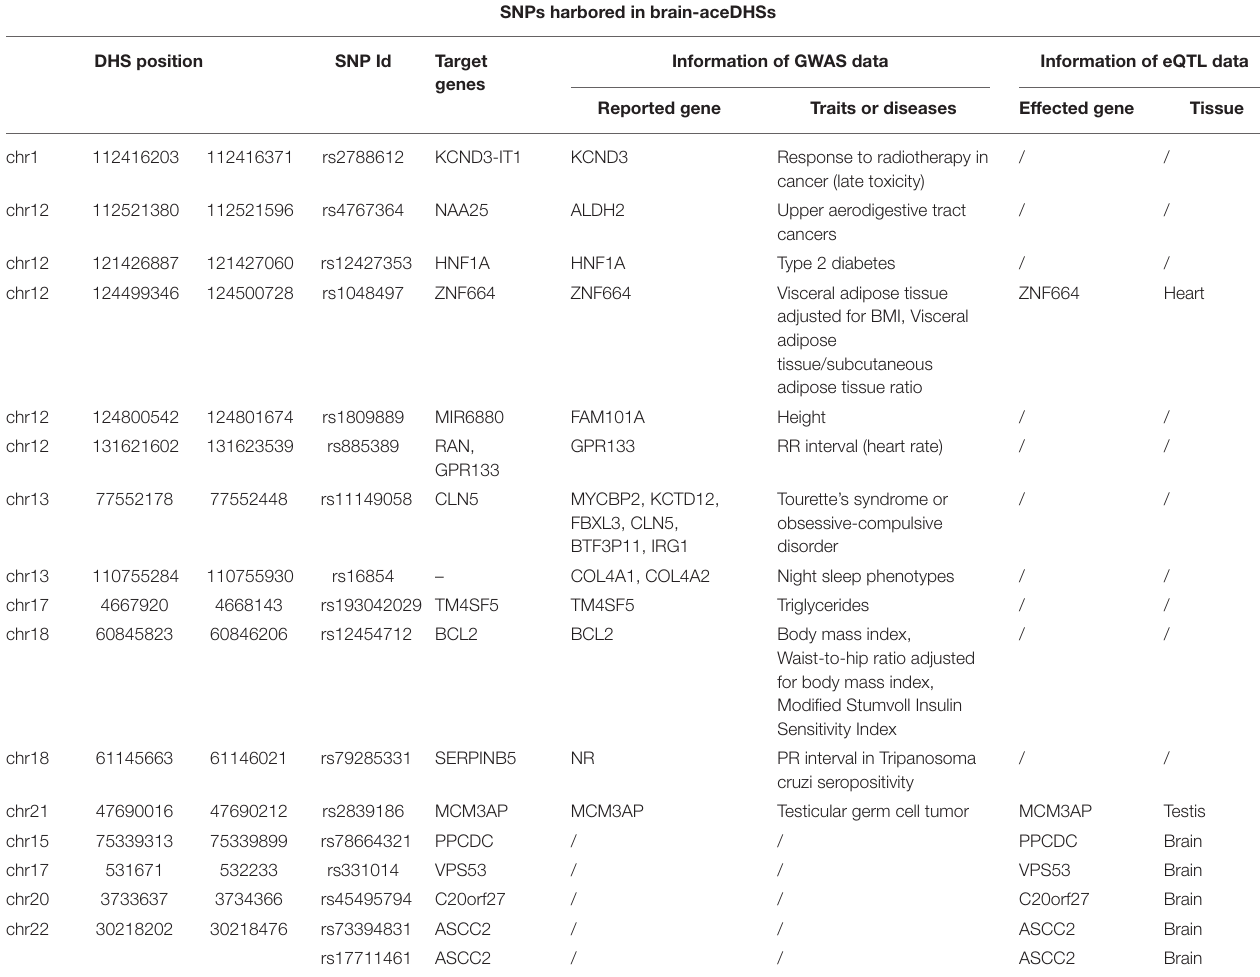
SNPs harbored in